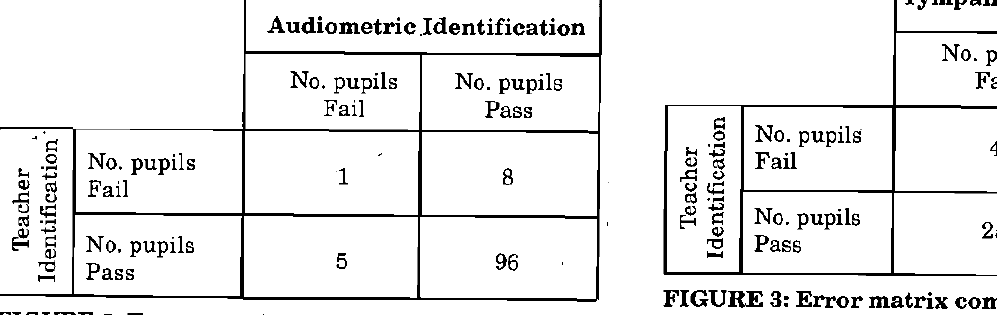
FIGURE 2: Error matrix comparing teacher identi- fication with audiometric identification